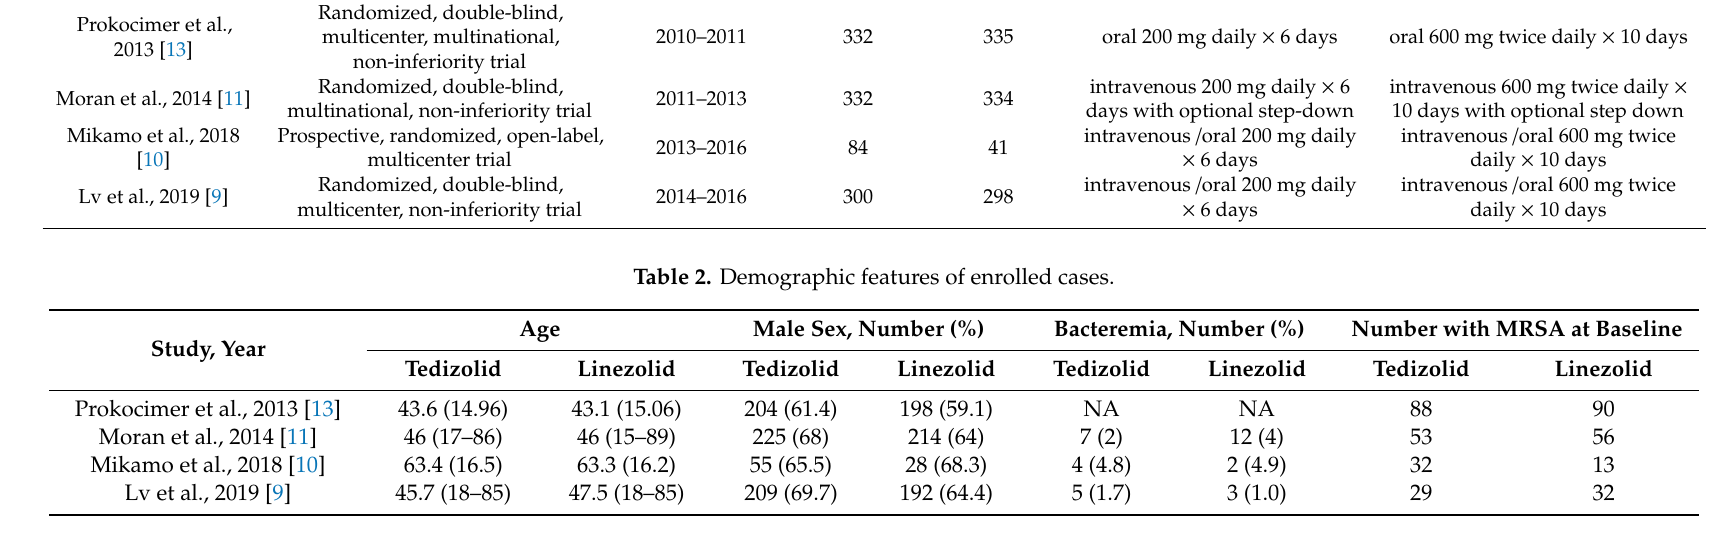
Table 3. Type of